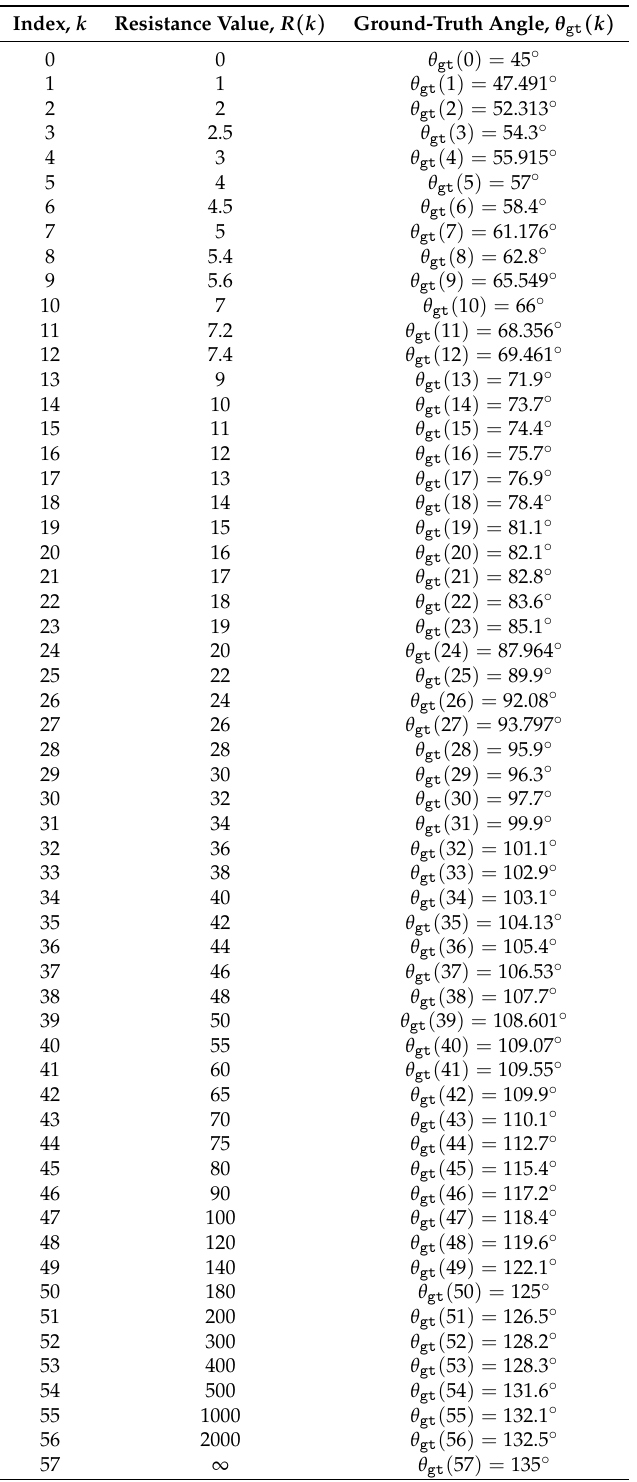
Table 2. Nonlinear mapping table built for measuring the resistance from the pointer ( θ p ) indication on the Ω -scale ∈ R IM where the ground-truth angle θ gt ( k ) corresponded to the resistance value ( R ( k ) ) which was obtained by means of a protractor. The values listed here were used in the current